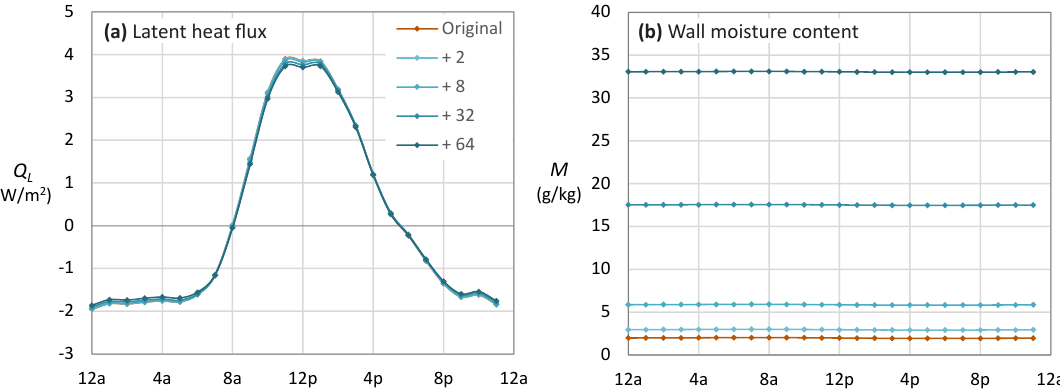
Figure 13. Effect of varying the absolute value (keeping slope constant) of the moisture retention curve W (Figure 11b) on ( a ) latent heat flux Q L and ( b ) moisture content M in unfired earth brick walls, illustrating the relative unimportance of the absolute value of W for Q L , as well as the independence of Q L from M . Data show average hourly July values in the marine west coast climate of Clermont-Ferrand, FR (Köppen Cfb , Table 3; Figure 9) for south-facing walls; the Original is Cagnon’s Unfired Earth Brick 1 [50]. Ambient humidity was the only source of